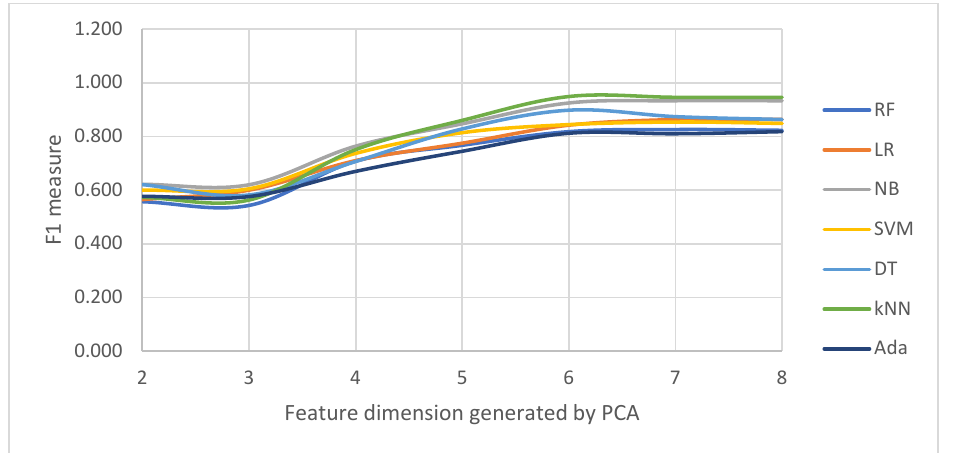
Fig. 12. F1 results for the comparison between different machine learning models using